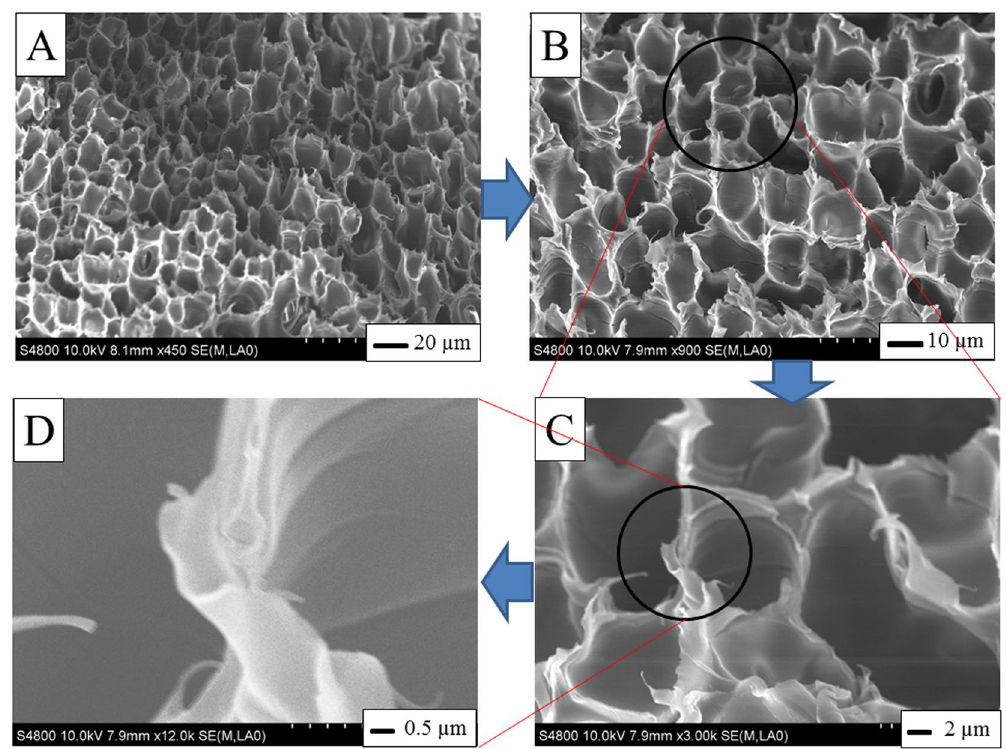
Figure 2. SEM images of a PS monolith at different